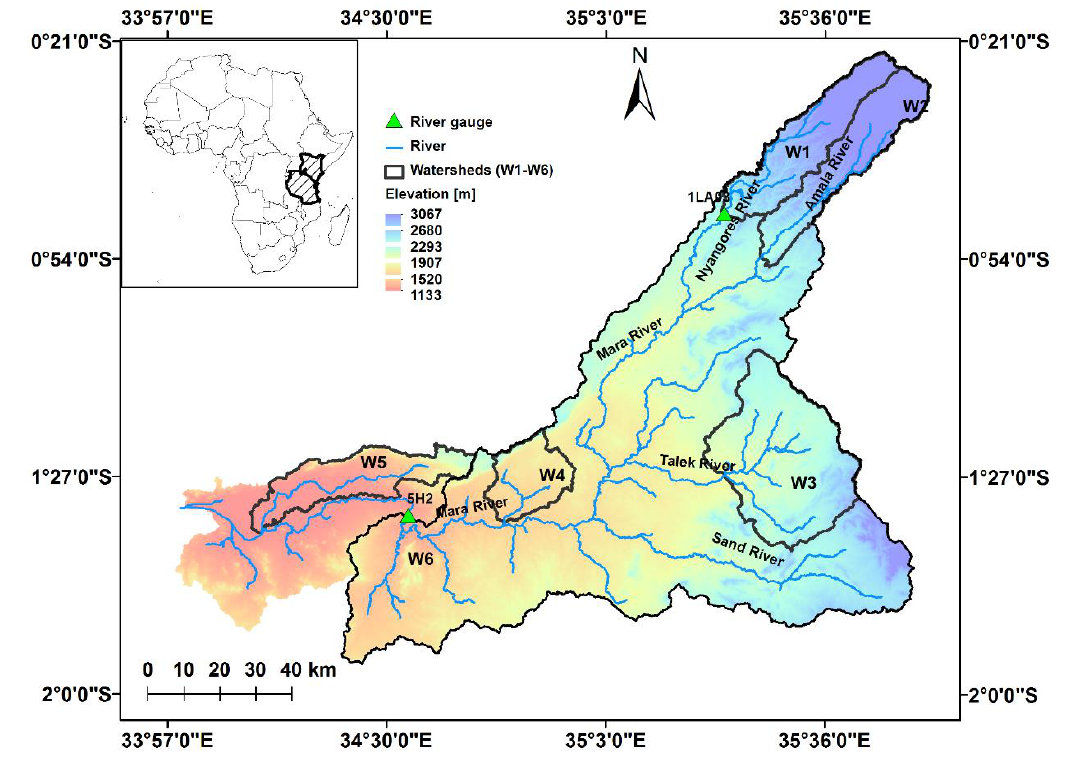
Figure 2. The location of the Mara Basin in East Africa. Selected sample watersheds with varying aridity and landscape characteristics are marked with W1–W6. The inset map shows the boundary of Kenya and Tanzania. Table 1. Summary of selected watershed characteristics. P , ET 0 and ET represent mean annual (2002–2009) rainfall and reference and actual evapotranspiration, respectively. See their location in Figure 2 and note that W1 and W6 are watersheds with gauging